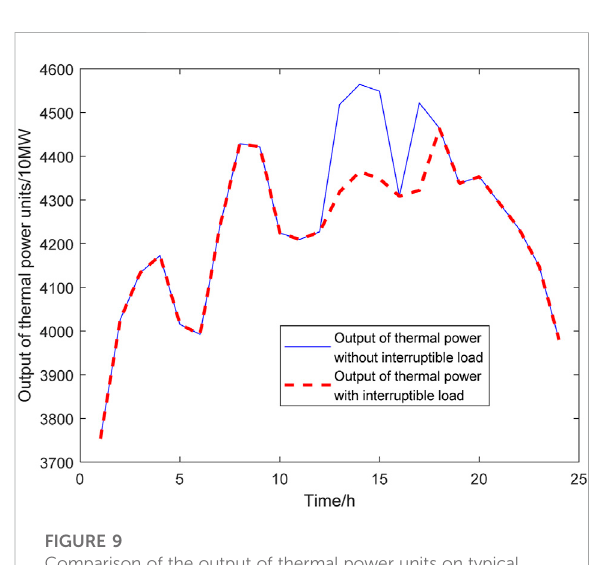
FIGURE 11 Comparison of the output of thermal power units on typical day 1 with 6 million kW interruptible